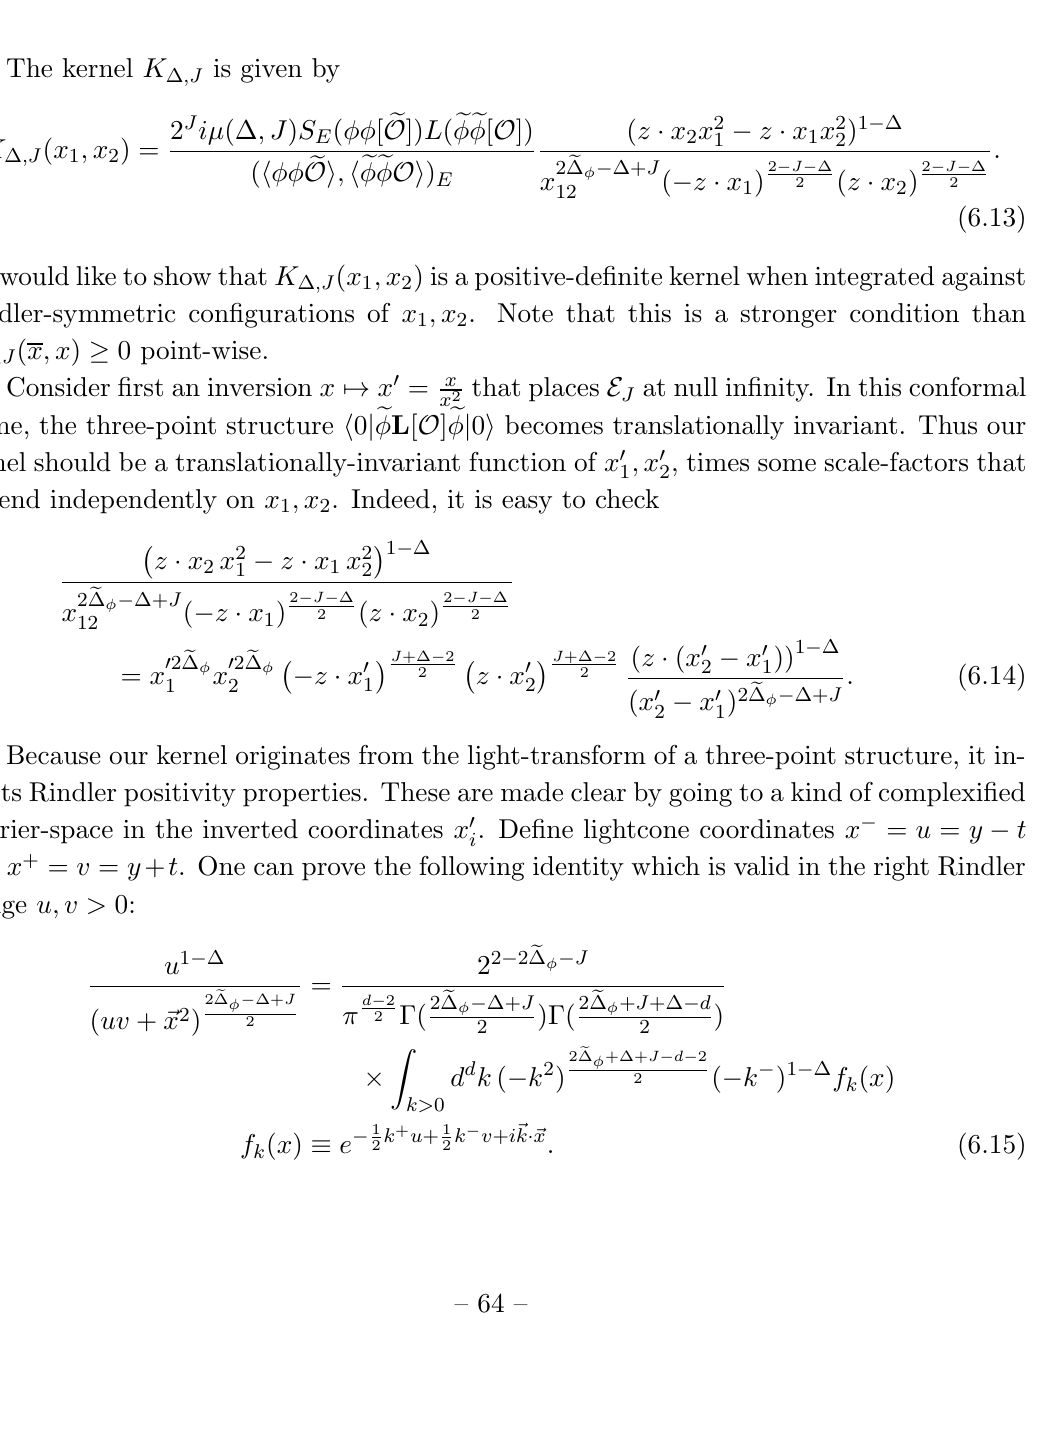
V i is negative for (cid:1) between d (cid:1) ;J